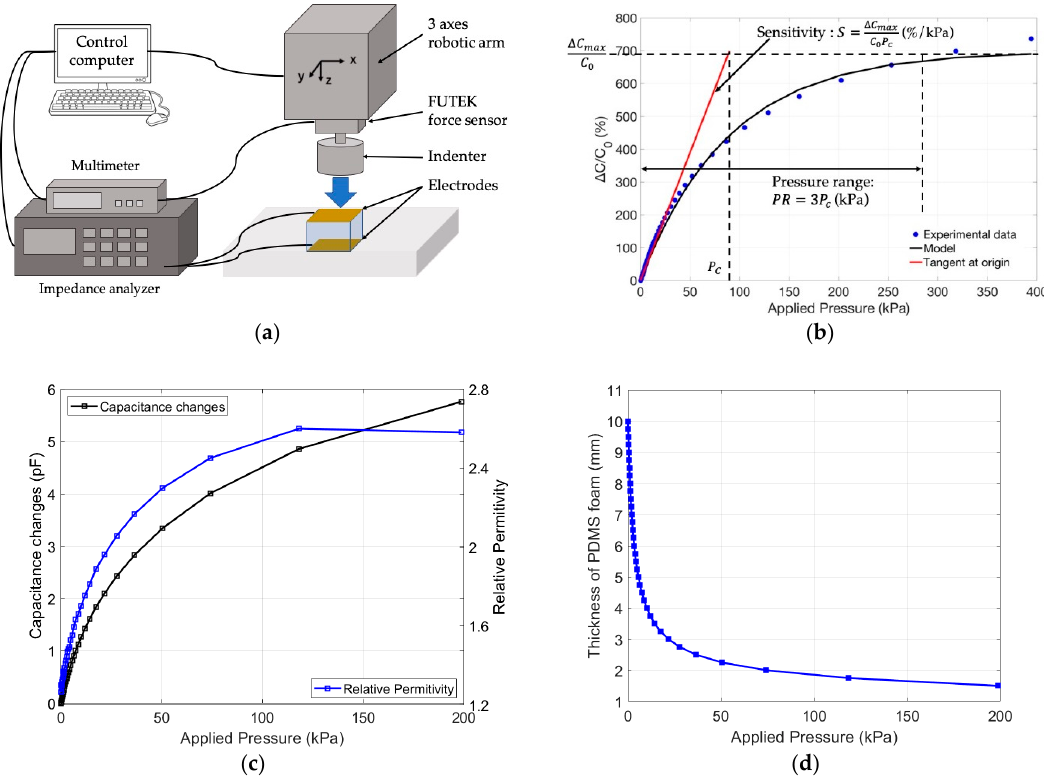
Figure 4. ( a ) Electromechanical test bench used to measure the sensor response curve (capacitance change versus applied pressure); ( b ) Typical sensor response curve (blue dots) for a sensor featuring a 6:1 small pore foam and first order exponential behavior model (black line) allowing sensor sensitivity ( S ) and pressure range ( PR ) to be defined and estimated from the characteristic pressure P C and the maximum relative capacitance change Δ C max /C 0 . ( c ) Capacitance changes (black line) and foam permittivity changes (blue line), versus applied pressure, for a sensor featuring a 6:1 small pore foam layer; ( d ) Changes of the PDMS foam thickness d with applied pressure for a sensor featuring a 6:1 small pore foam layer.